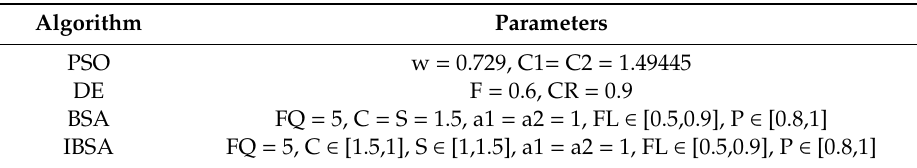
Table 2. The parameters of di ff erent algorithms.